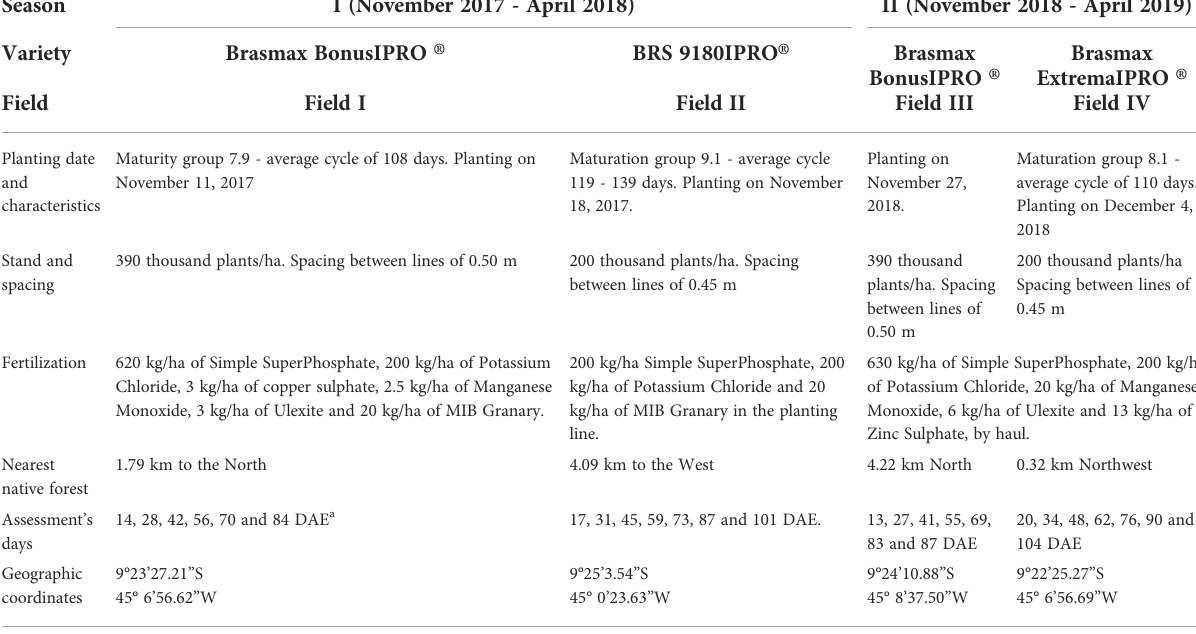
TABLE 1 Phenological cycle, fertilization, plant population, planting date, distance from cultivars to the nearest native forest, and evaluation days by cultivar in the two seasons